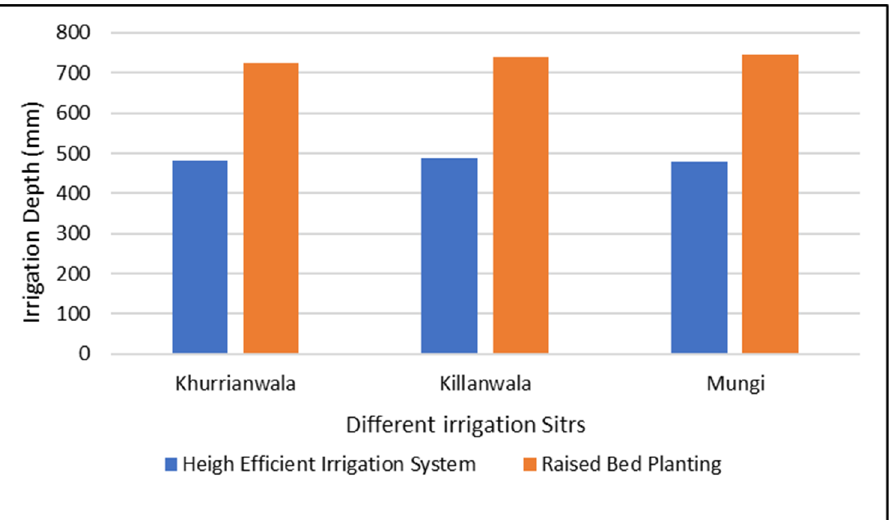
Figure 5. Comparison of irrigation depth (mm) for maize crop, sown at different sites [15].